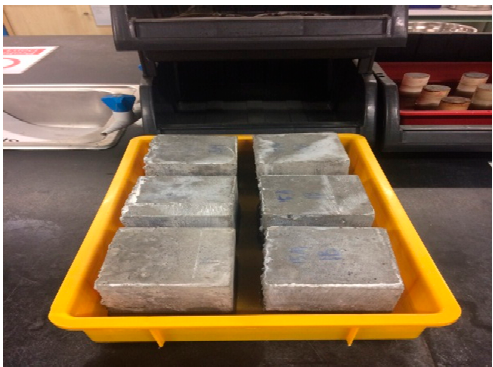
Figure 4. Immersion for efflorescence test.